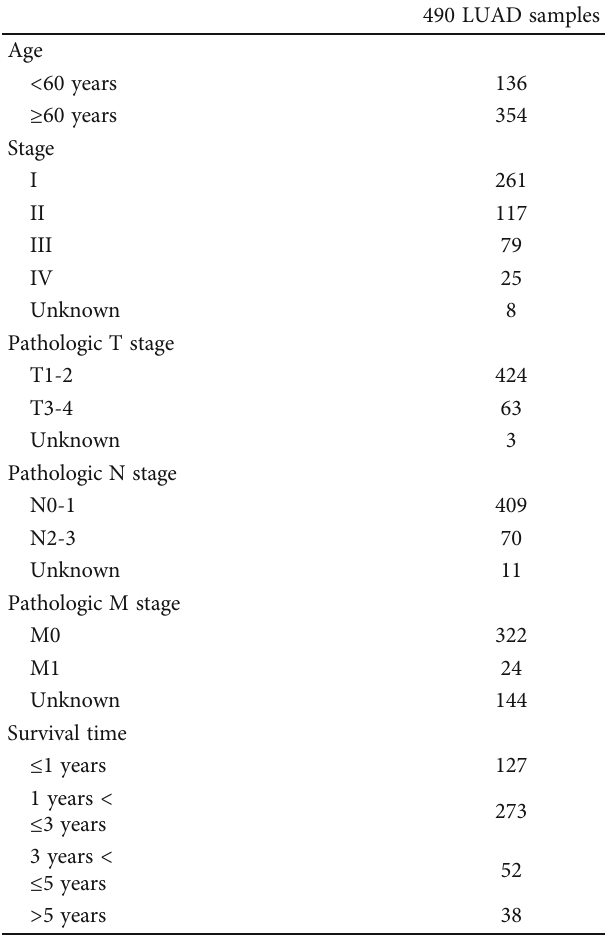
Table 1: The speci fi c baseline clinicopathological characteristics of 490 LUAD